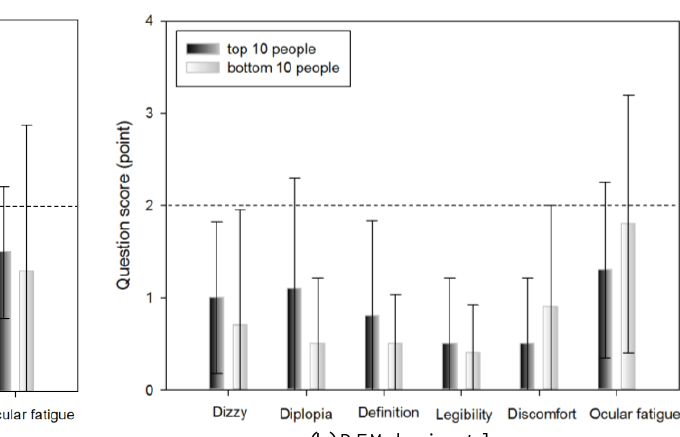
VHD horizontality Top 10 people (31.89±2.17) Bottom 10 people (47.99±5.62) SD: standard deviation Mann-Whitney